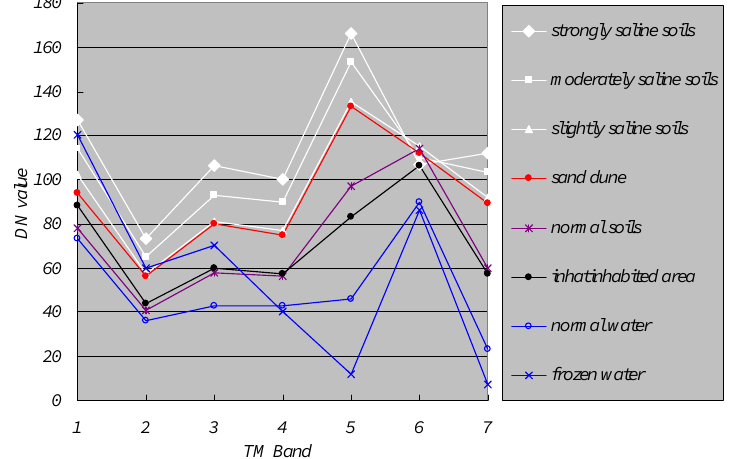
Figure 4. Typical spectral response in Landsat TM (upper: 2001-03-11, lower